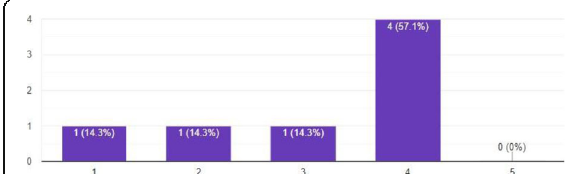
Fig. 9 Results of the answers for question Q4: “ How likely is it that you would use this in coaching? ” Answers were in the form of a 5- point Likert